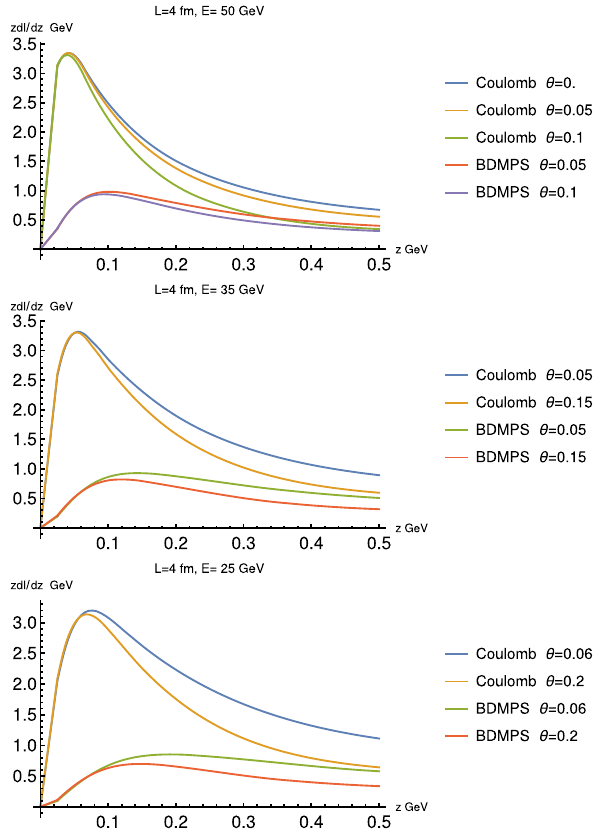
Fig. 7 The energy loss zdI/dz with ic gluons and BDMPS with phase constraints for different Energies and heavy quark masses m = 1 . 5 and 5 GeV